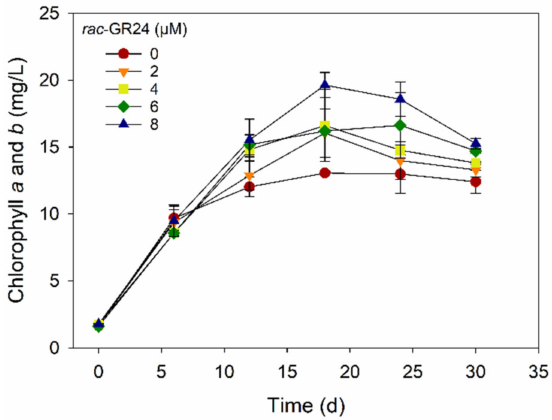
Figure 4. Time course profile of chlorophyll a and b concentration during the 30-d photosynthetic cultivation of H. pluvialis under different rac -GR24 concentrations (2.0–8.0 µ